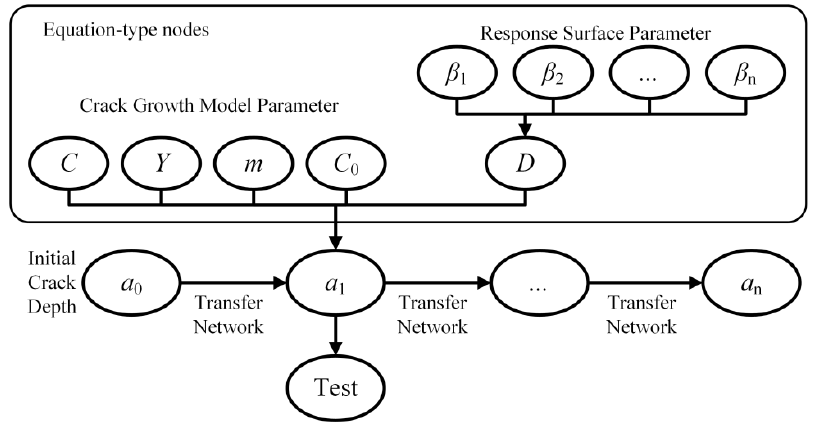
Figure 5. Fatigue crack DBN model of riser.